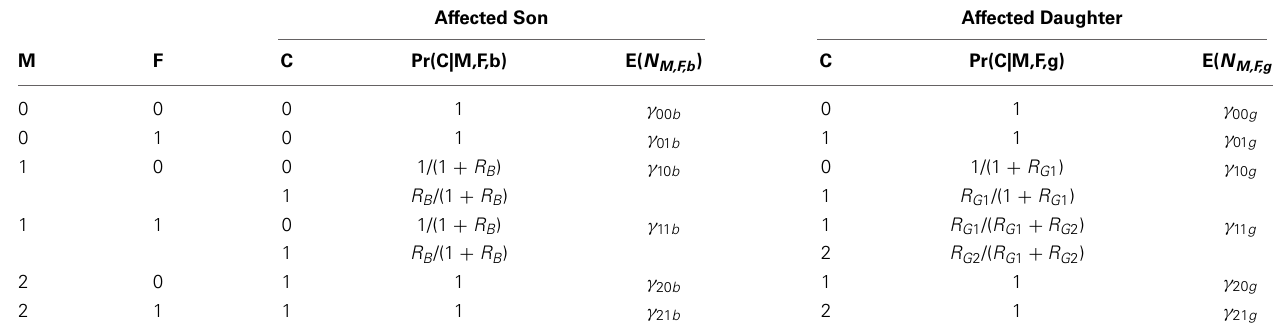
Table 2 | For affected sons and daughters, case-parent genotype probabilities using transmission